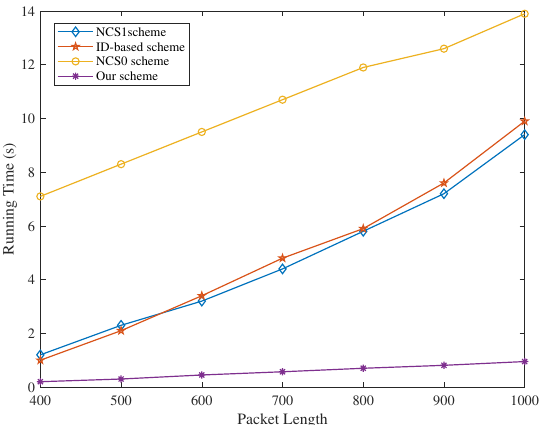
Figure 4. The running time of signature, encryption, and verification in different schemes against packet